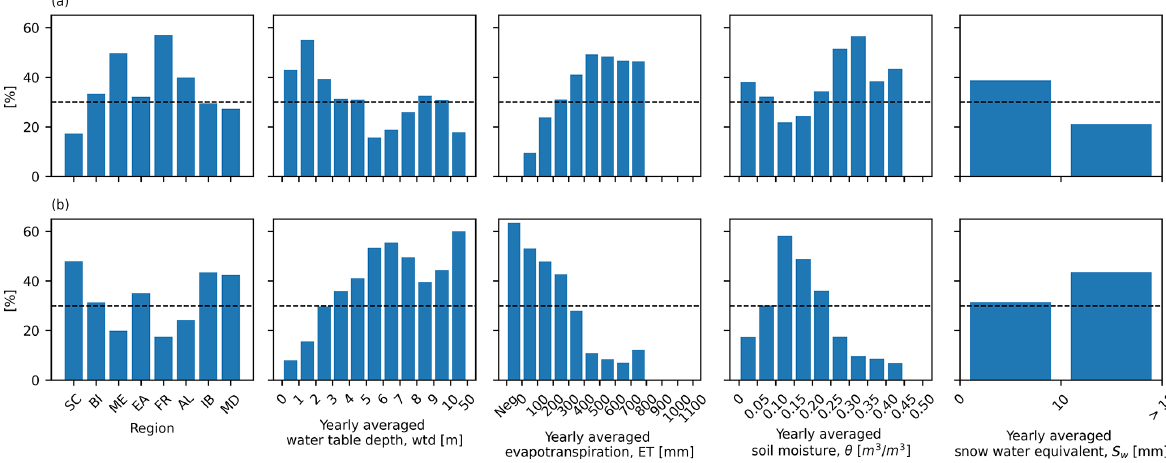
Figure 8. Bar plots showing the percentages of pixels where the network performance followed the combinations (a) C1, (b) C2 in different regions and intervals of yearly averaged wtd, ET, θ , and S w , from left to right, respectively. Black dashed lines indicate percentages equal to